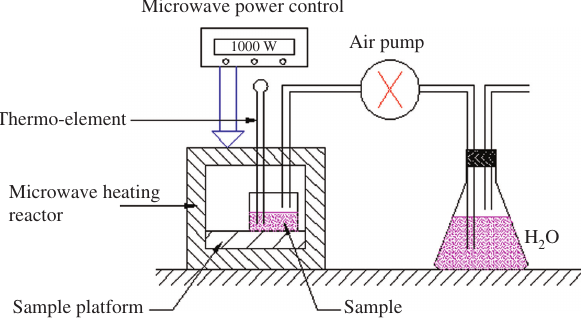
Table 1: Proximate analyses of Eupatorium adenophorum .